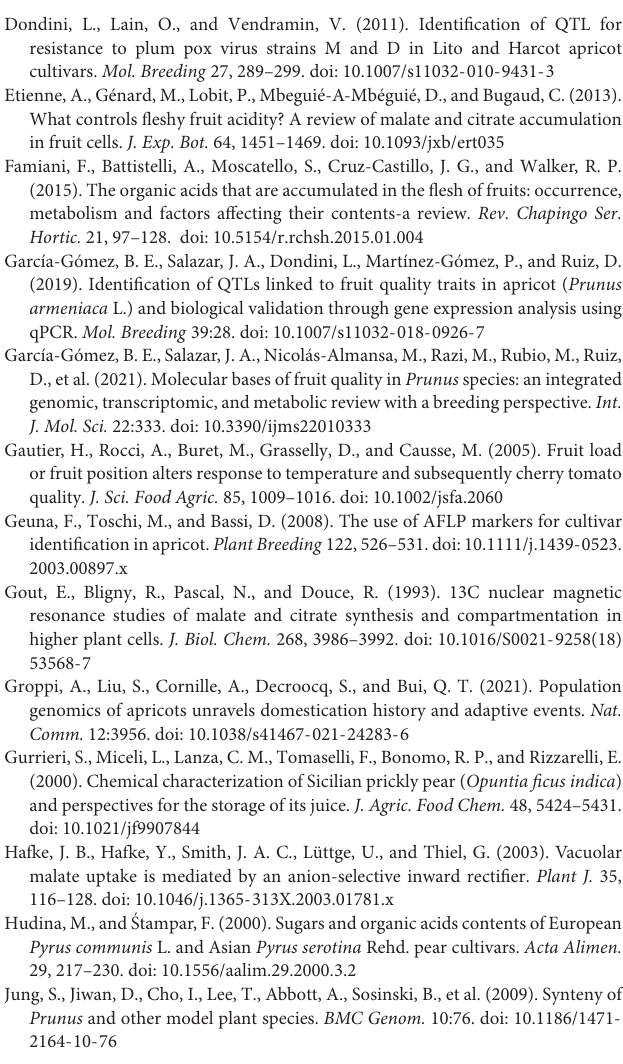
Supplementary Table 5 | Alignment of the genetic and physical maps of ‘Lito.’ The position of markers is expressed in cM and in bp for each of the ‘Stella’ chromosomes. The list of markers that were not found in the ‘Stella’ genome sequence is also reported. Supplementary Table 6 | Names, genomic location, and predicted function of the acidity-related candidate genes found in the ‘Stella’ apricot gene database. The quantitative trait loci (QTLs) associated with each gene is also